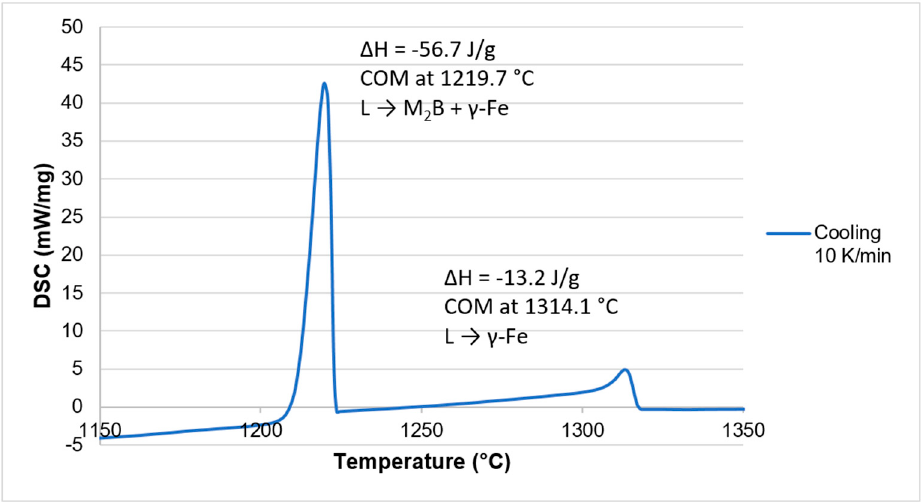
Figure 16. Differential scanning calorimetry cooling curve; phase transformations during solidifica- tion from 1400 °C.